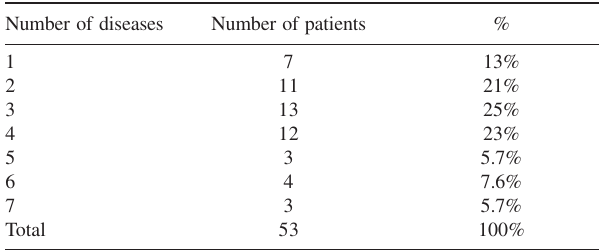
Table 4 - Number of preexisting diseases per patient Number of diseases